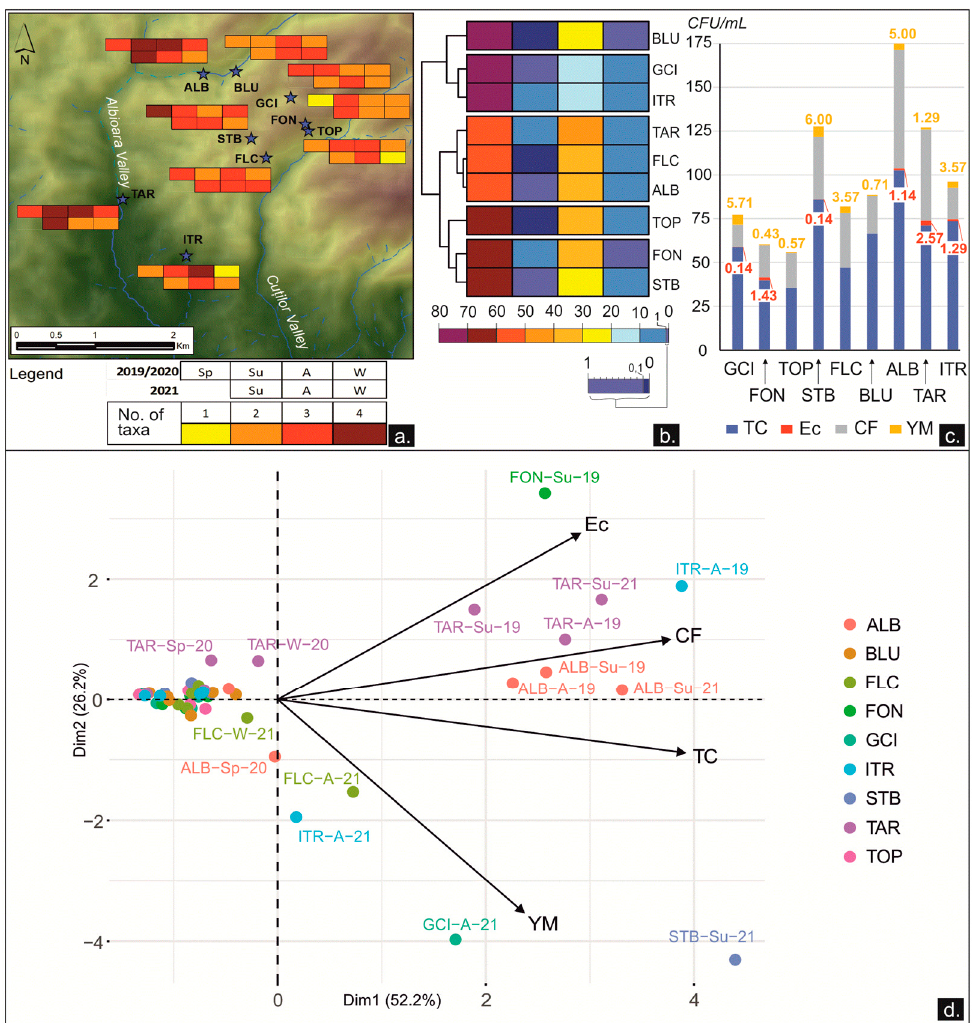
Figure 5. The microbial contaminants in the studied freshwater sources from the KSRP, 2019–2021: ( a ) spatial diversity of major taxa; ( b ) heatmap of the relative abundances and dendrogram of the KSRP freshwater sources; ( c ) the microbial averages of the sampled water sources from the KSRP; ( d ) PCA biplot based on the microbial content of the water samples. The three-letter acronyms correspond to sampled freshwater sources (see Table 1); Sp = spring, Su = summer, A = Autumn, W = winter; 19 = year 2019, 20 = year 2020, 21 = year 2021; TC = total count of heterotrophic micro- organisms, Ec = Escherichia coli , CF = coliforms, YM = yeast and molds. Vectors represent variables used to build the principal components. Only samples that were projected more than 0.5 cos 2 on the 2 axes are listed. For clarity, samples closely clustering together are represented without labels.